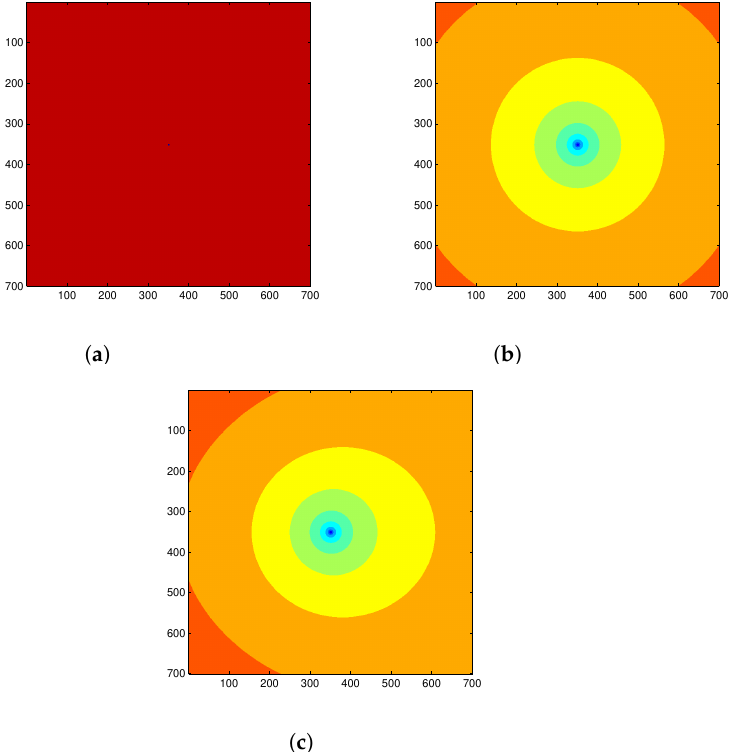
Figure 2. Basin of attraction for function Example 1, F 1 ( z ) = z α ( α = 1/3 ) by different methods. ( a ) Newton method (2), ( b ) Damped Newton method (8) at h = 0.50, ( c ) Damped Proposed method (12) at h = 0.50 and λ =